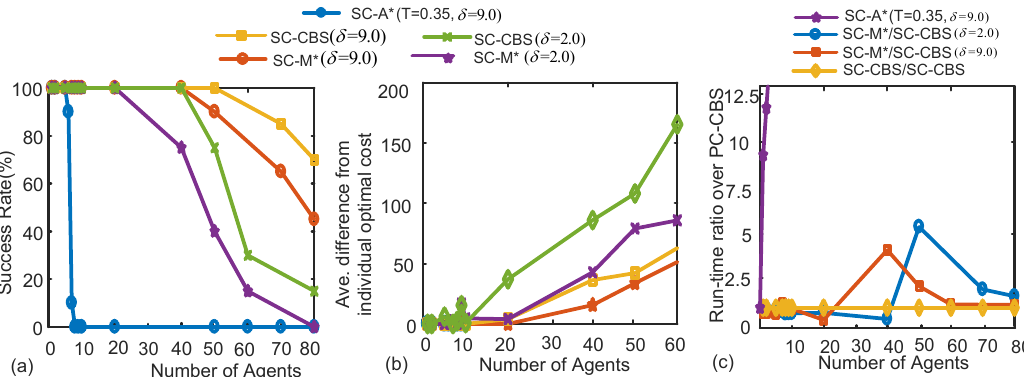
Figure 10. Success rate, cost, and run-time ratio of the three SC-based MAPP solvers under different δ